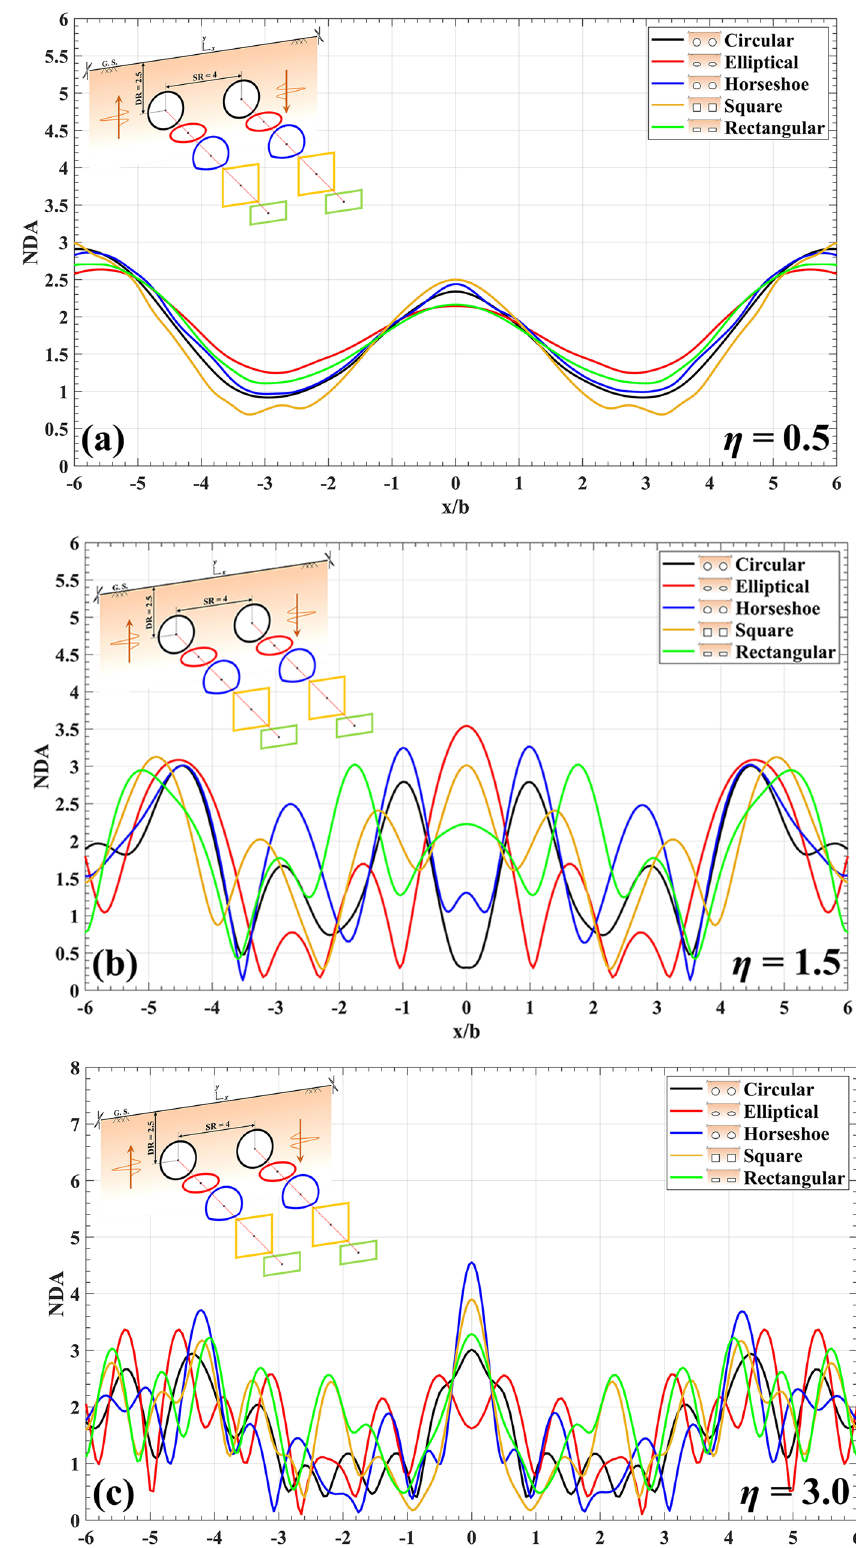
Fig. 11 The normalized dis- placement amplitude of the ground surface versus x ∕ b , for the model of twin lined tun- nels with different geometries and dimensionless frequency of a 𝜂 = 0.5 , b 𝜂 = 1.5 and c 𝜂 = 3.0 subjected to the verti- cal incident SH